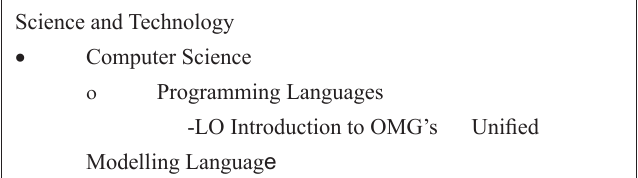
Introduction to OMG’s